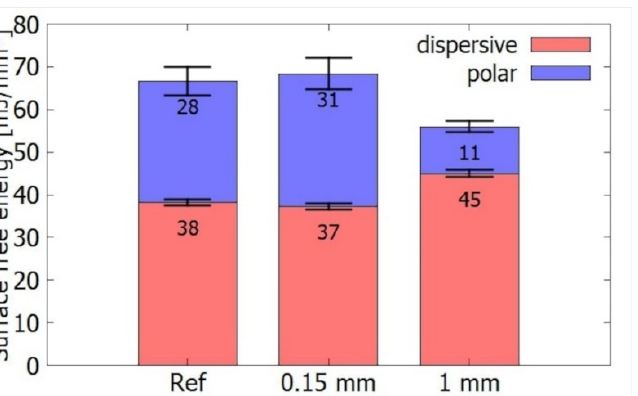
Figure 4. Comparison of surface energies of thermally unmodified wood at different distances from the electrode in the air atmosphere.